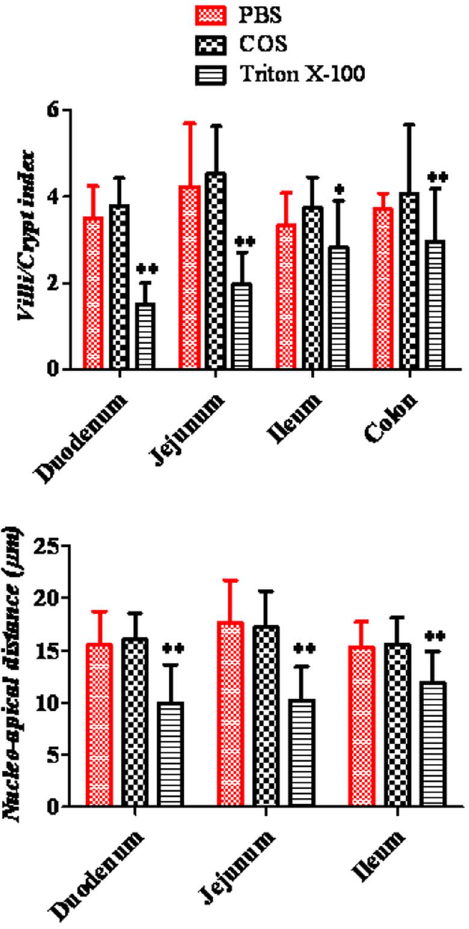
Figure 7. Nucleo-apical distance ( m m) for duodenum, jejunum and ileum and villi index for duodenum, jejunum and ileum, and crypt index for colon for COS at the dosage of 25 mg/kg. Results are presented as mean values 6 S.D. ( n =4–6). ( * ) P , 0.05 and ( ** ) P , 0.01 compared with the PBS group.